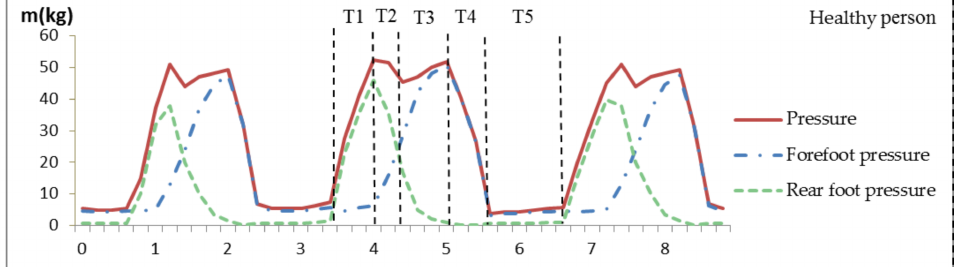
Figure 10. Pressure curves of healthy person gait.